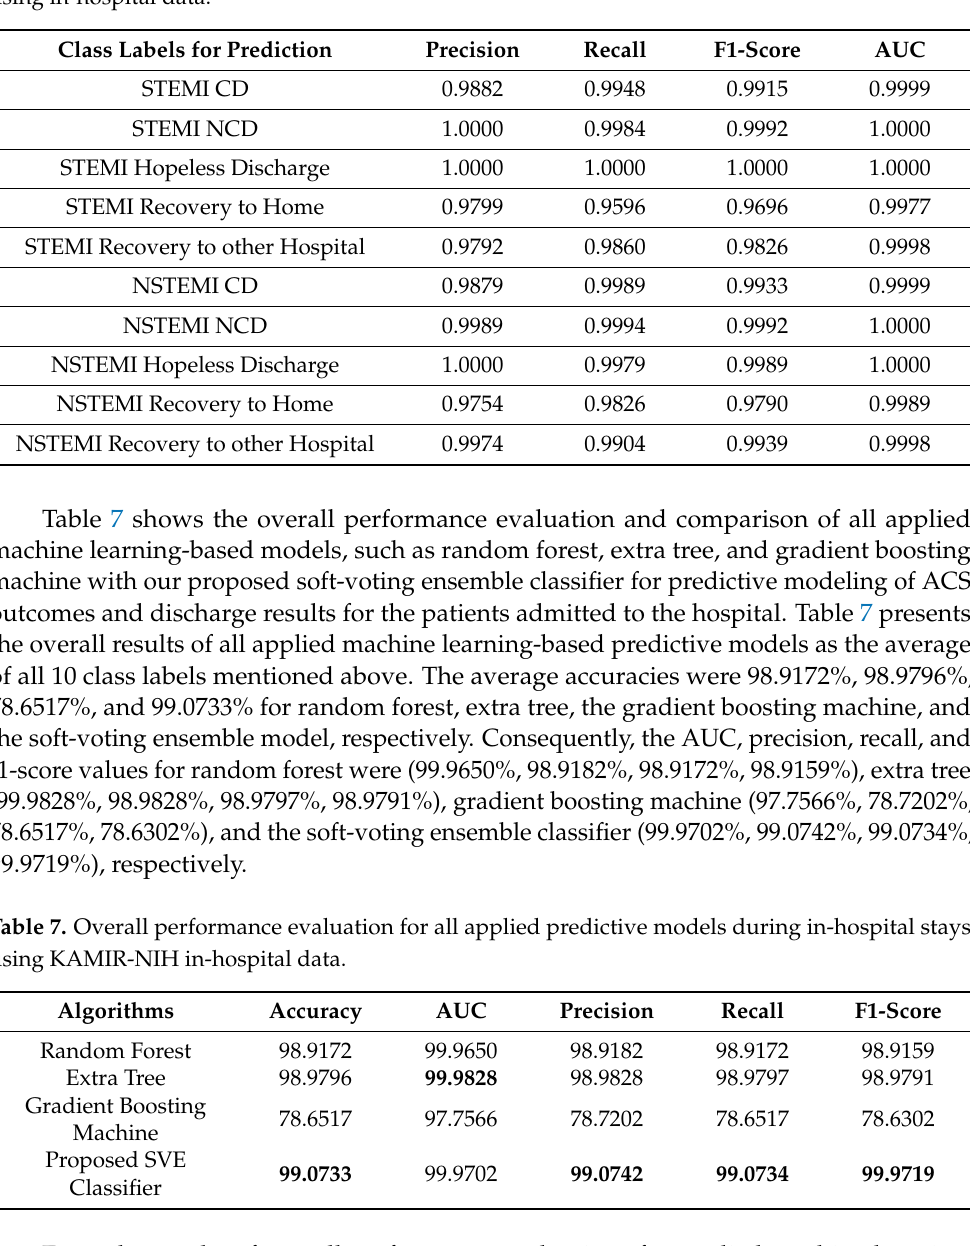
Table 6. Performance measures of all class labels for the proposed Soft Voting Ensemble Classifier using in-hospital data.